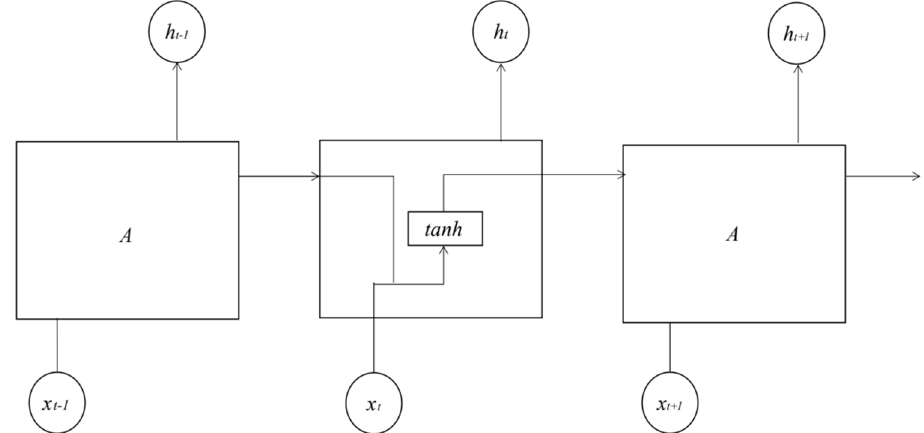
Figure 3. The internal structure diagram of neurons of cyclic neural network.